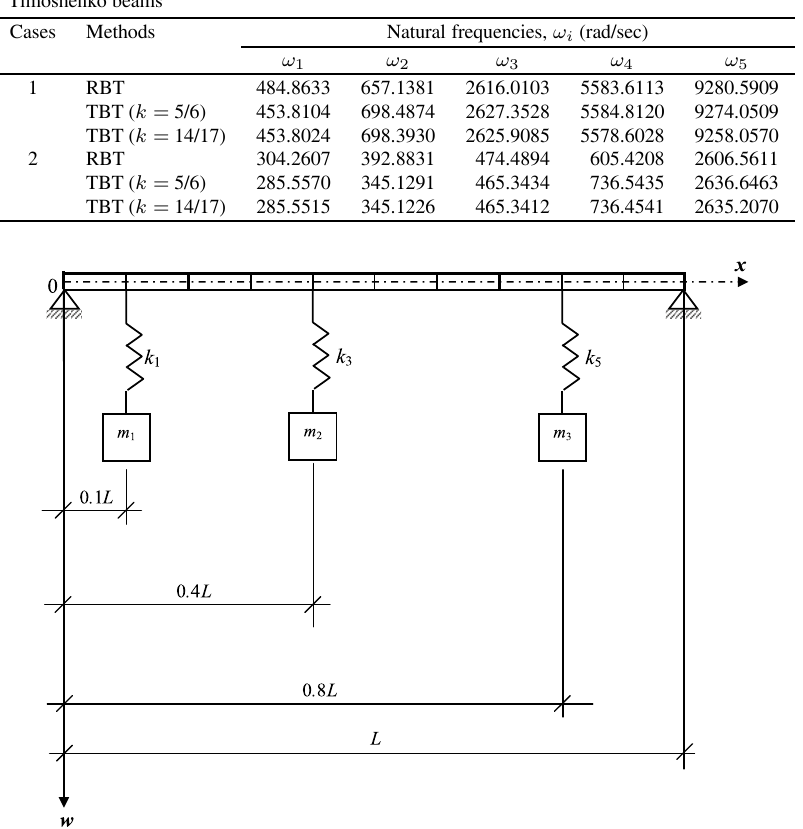
Table 2 The fi rst fi ve natural frequencies of the uniform single-span pinned-pinned Reddy-Bickford and